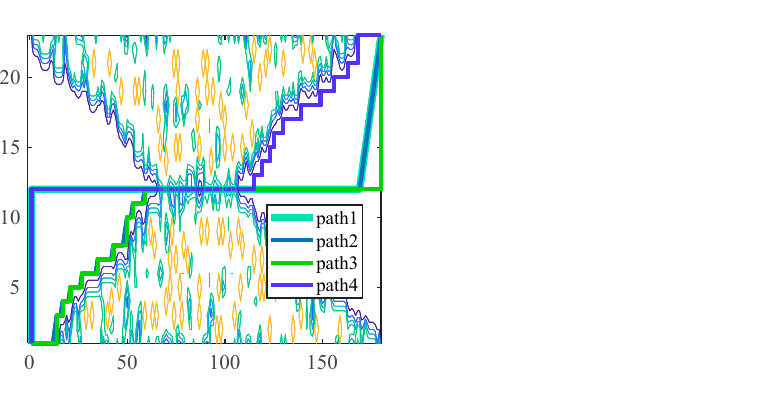
Figure 28. Collision-free paths founded by the MDPF algorithm in the map with a dangerous potential field for case 2.